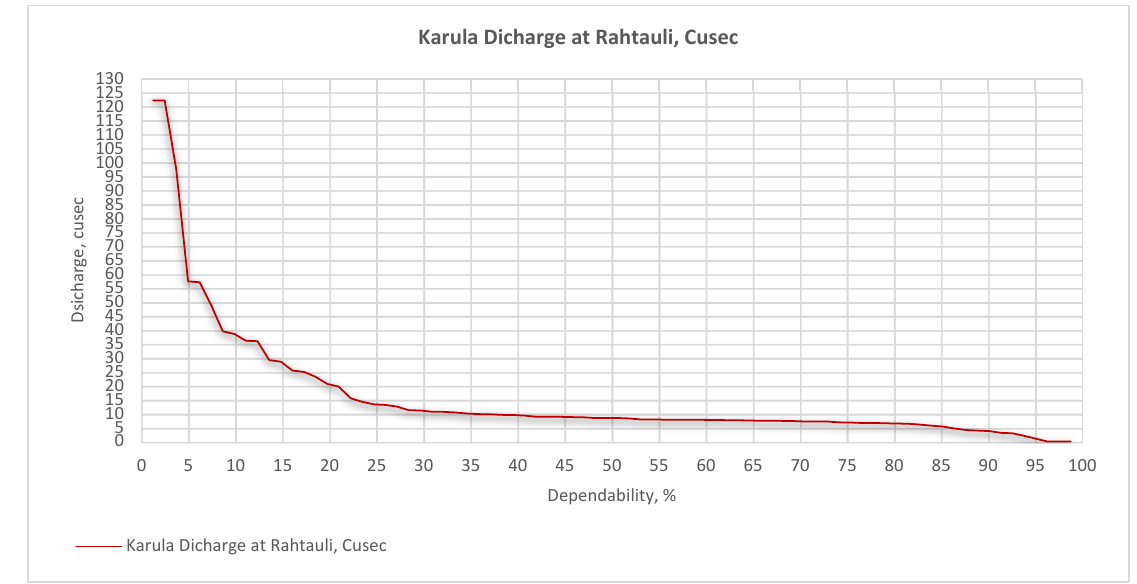
Figure 1. The Flows Dependability Curve of Observed Discharges in Karula River at Rahtauli village point and hydrological variations in the Karula River from 2017 to 2021.